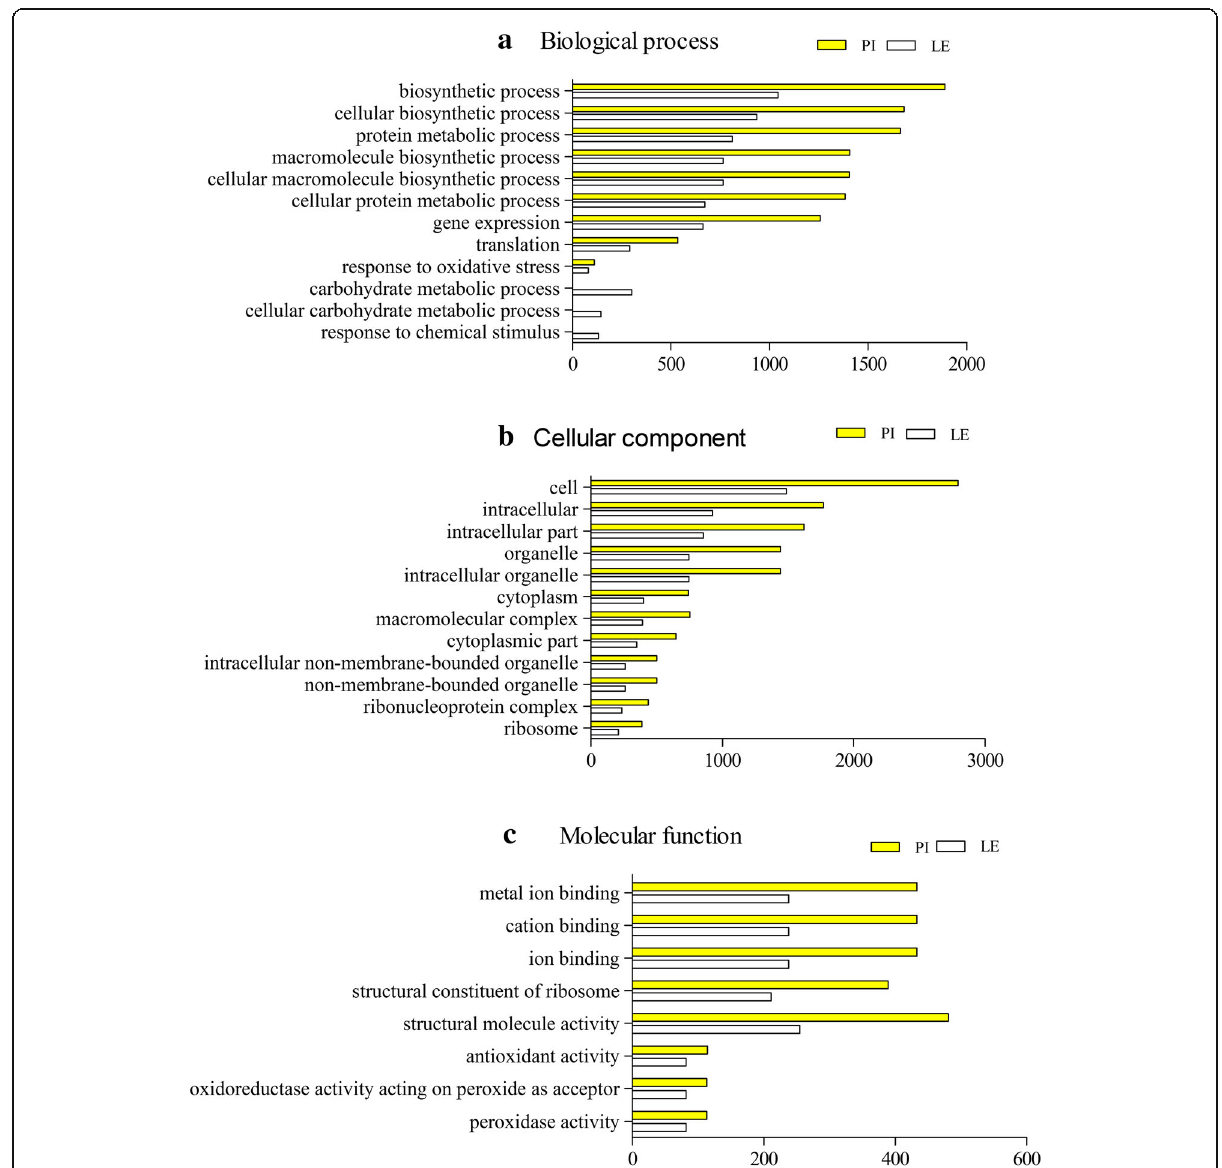
Fig. 4 GO annotation clusters of DEGs. GO functional enrichment analysis of DEGs in the roots of different allelopathic rice accessions. Based on sequence homology, 18,879 genes were distributed among the three main categories: a , biological process; b , cellular component; and c , molecular